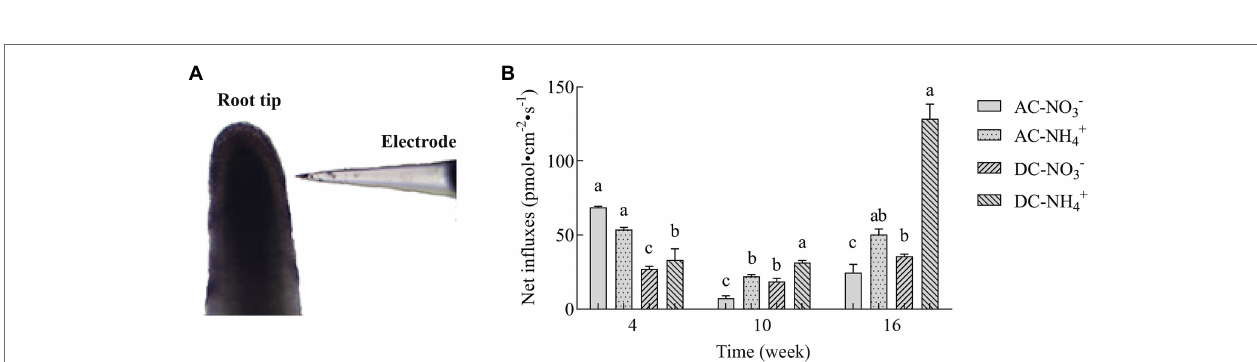
+ and NO 3 − influx. Bars labeled with different letters indicate significant 4